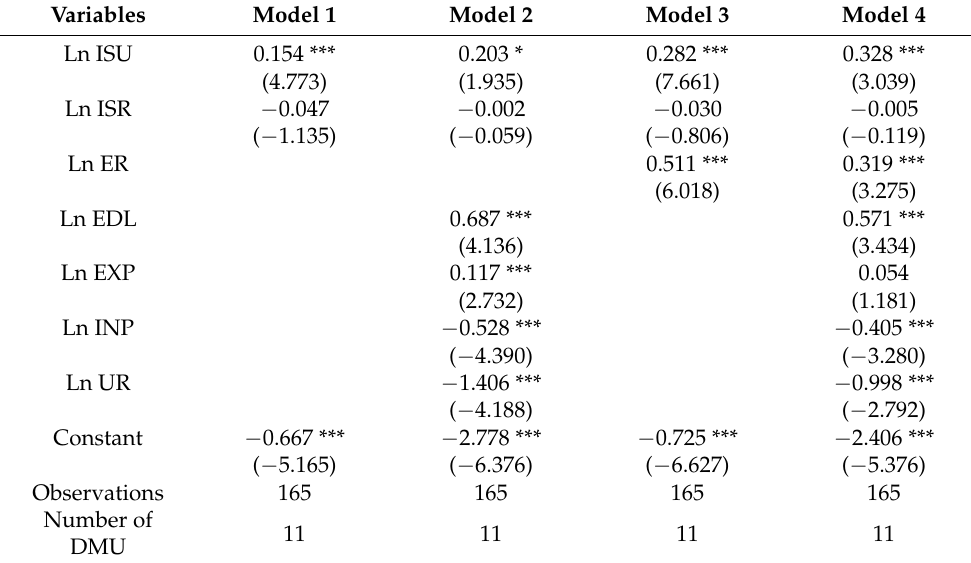
Table 5. Regression results of industrial structure affecting